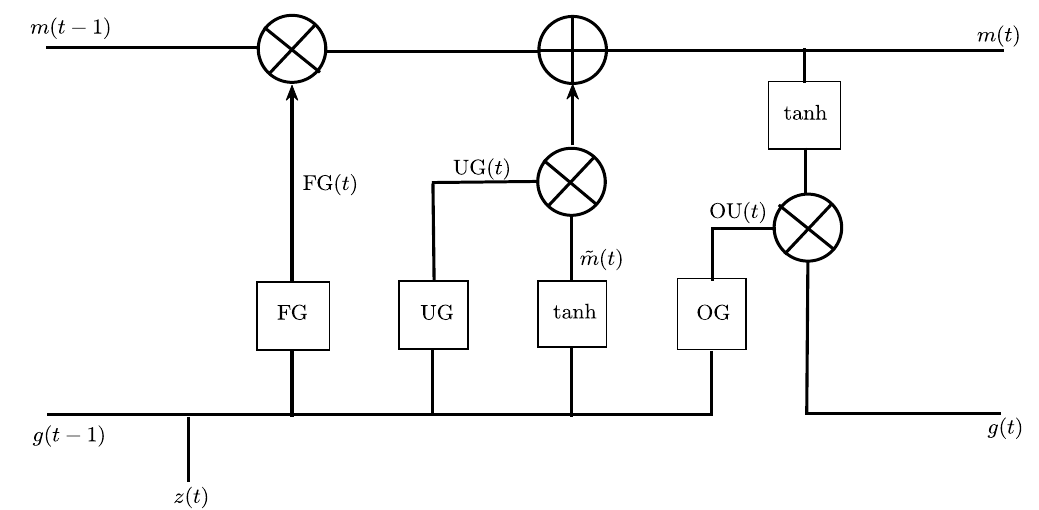
Figure 6. Block-diagram of a single LSTM